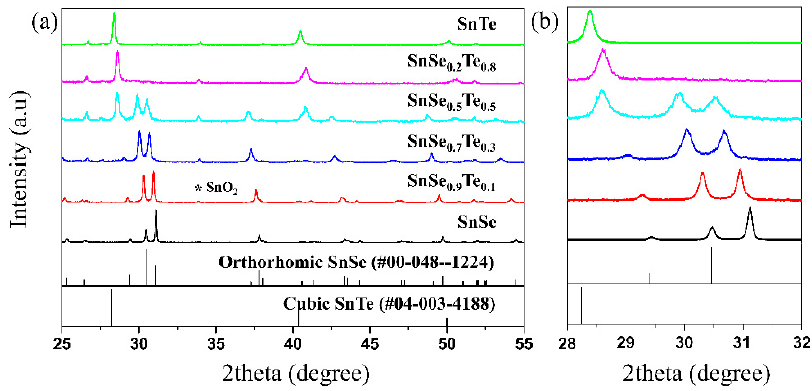
Figure 1. ( a ) Theta-2theta X-ray diffraction (XRD) patterns of the polycrystalline SnSe 1 − x Te x (x = 0, 0.1, 0.3, 0.5, 0.8 and 1) and ( b ) featured 2 θ profiles on expanded scale.